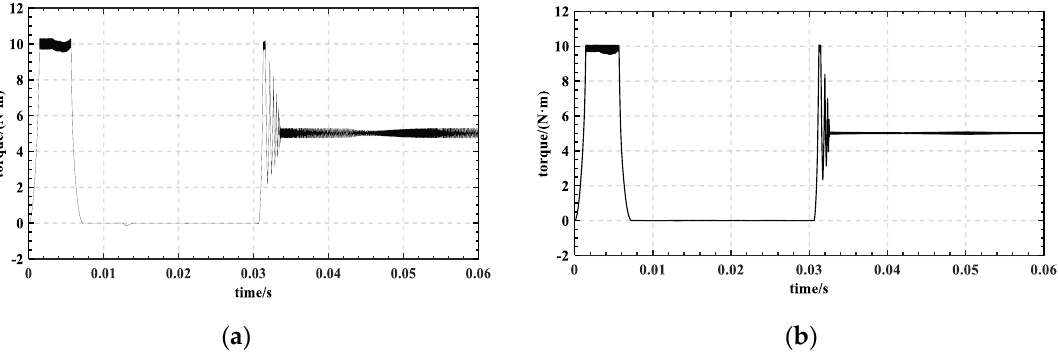
Figure 12. Torque comparison with 5 N load: ( a ) torque of PID control system and ( b ) torque of FNN control system.